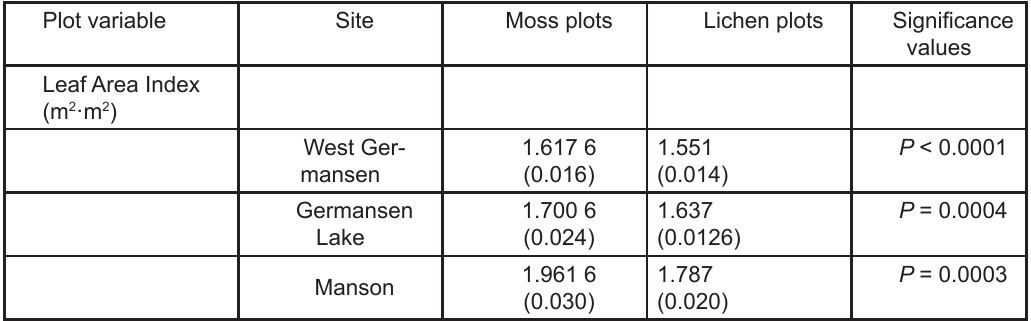
Table 1. Mean microplot values (± 1S.E.) for leaf area index in moss- versus lichen-dominated plots in pine lichen woodlands from central-interior British Columbia. Significance values are shown for t-test comparisons between ‘Moss’ and ‘Lichen’ plots at each location (from Sulyma & Coxson